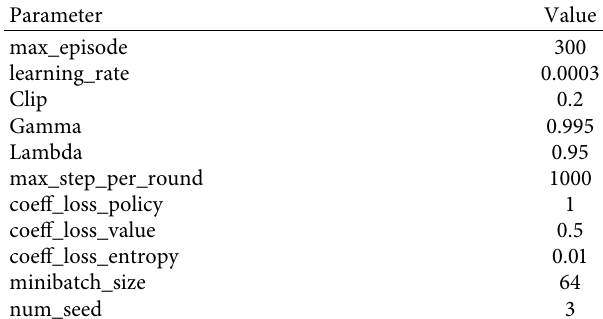
Table 5: Hyperparameter